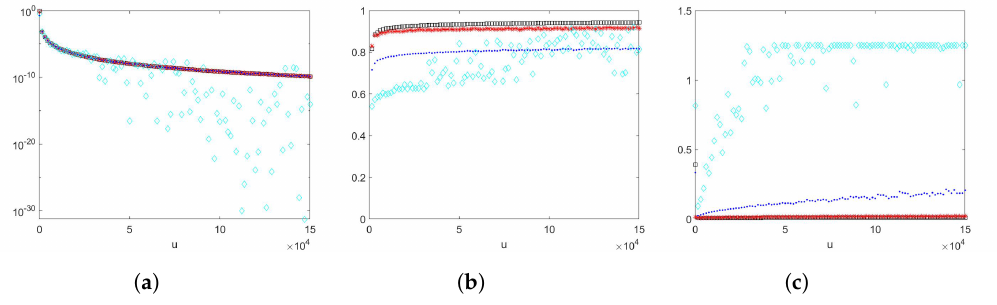
Figure 7. The random variable N is geometrically distributed with success probability p = 0.2, W i i.i.d ∼ LogN ( 2,2.25 ) , X i i.i.d ∼ Erlang ( 2,3 ) , where i = 1, . . . , N . Black squares: ConAK1+IS+CV (conditioning and IS on log-normal). Red stars: ConAK2+CV (conditioning on Erlang). Blue dots: ConAK2+IS+CV (conditioning and IS on Erlang using an exponential PDF). Cyan diamonds: ConAK2+IS+CV (conditioning and IS on Erlang using an Erlang PDF). ( a ) Estimates of (cid:96) ( u ) as a function of u on a logarithmic scale. ( b ) Empirical logarithmic rates as a function of u . ( c ) Empirical relative errors as a function of u